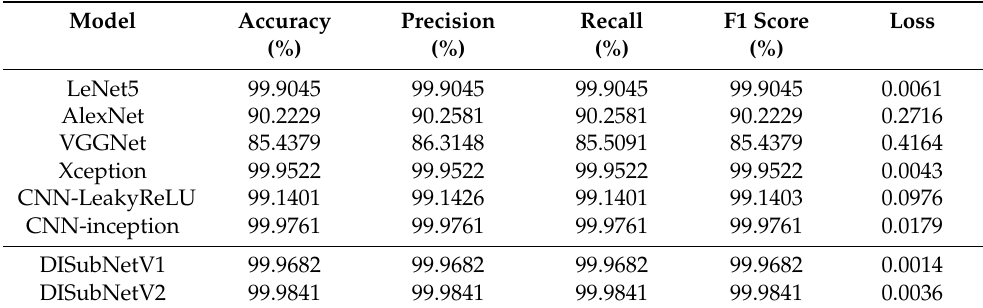
Table 1. Performance comparison of different models with learning rate =